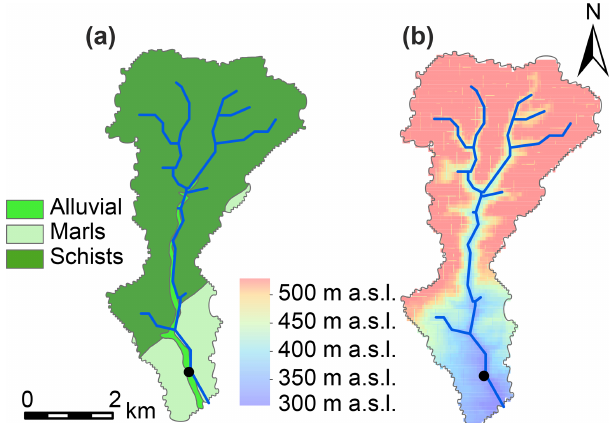
Figure 1. Geology (a) and digital elevation model (b) of the Col- pach catchment. The black dot marks the sampling location, which is located at the outlet of the catchment (i.e. the Colpach-Haut sub-